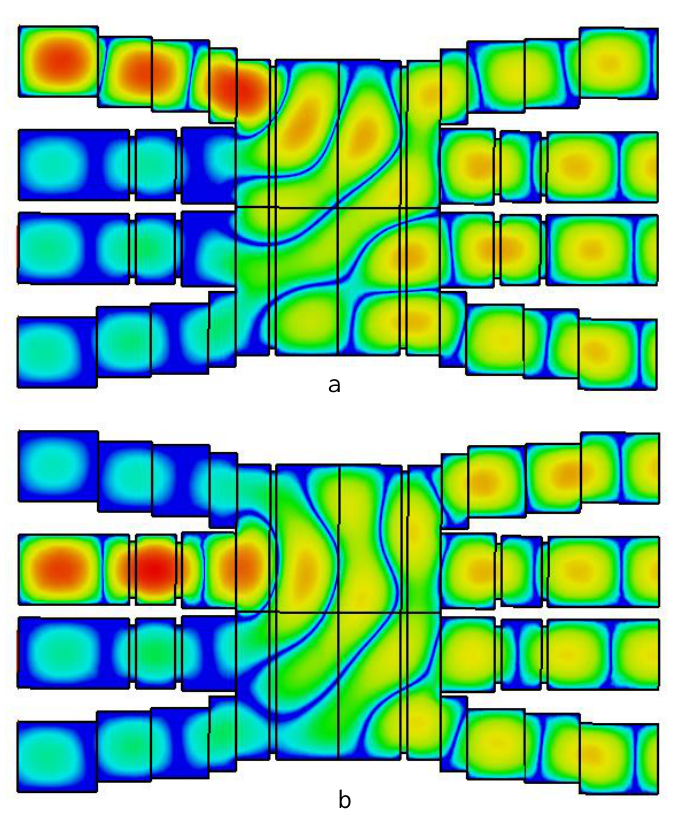
Figure 4. E -field distribution of the coupler when it is fed by: ( a ) Port 1 and ( b ) Port 2.